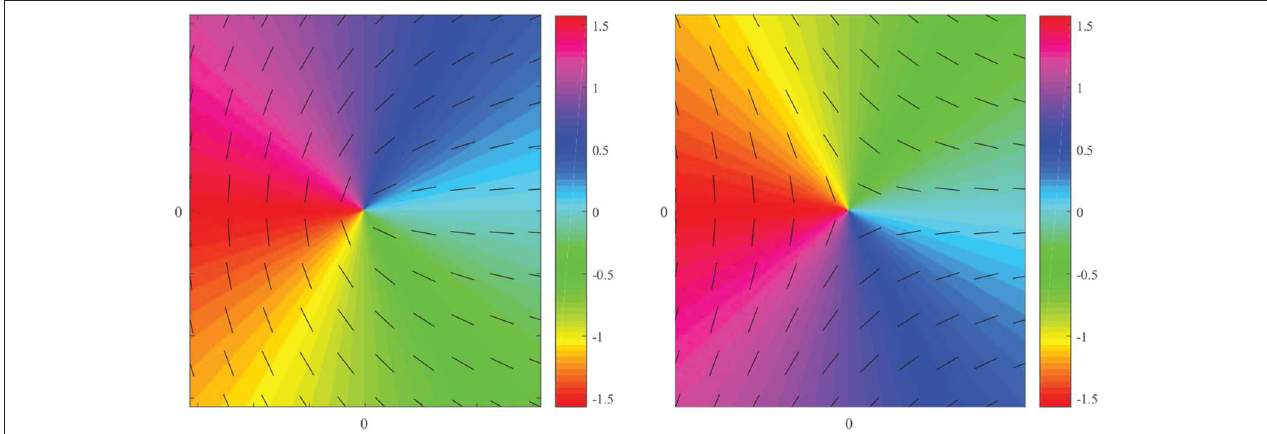
FIGURE 1 | Orientation of the major axis of the polarization ellipse for (left) a lemon ( n axis. The major axis is depicted two ways: with lines indicating the major axis direction for selected positions and with a colormap to indicate the value of 9